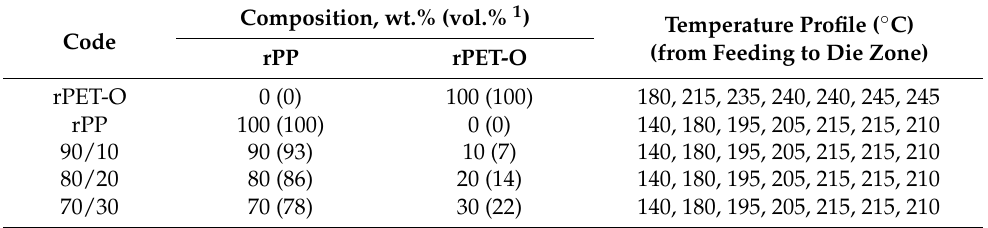
Table 1. Designation, composition, and extrusion temperature profile of calendered sheets. Composition, wt.% (vol.% 1 ) Temperature Profile ( ◦ C) Code